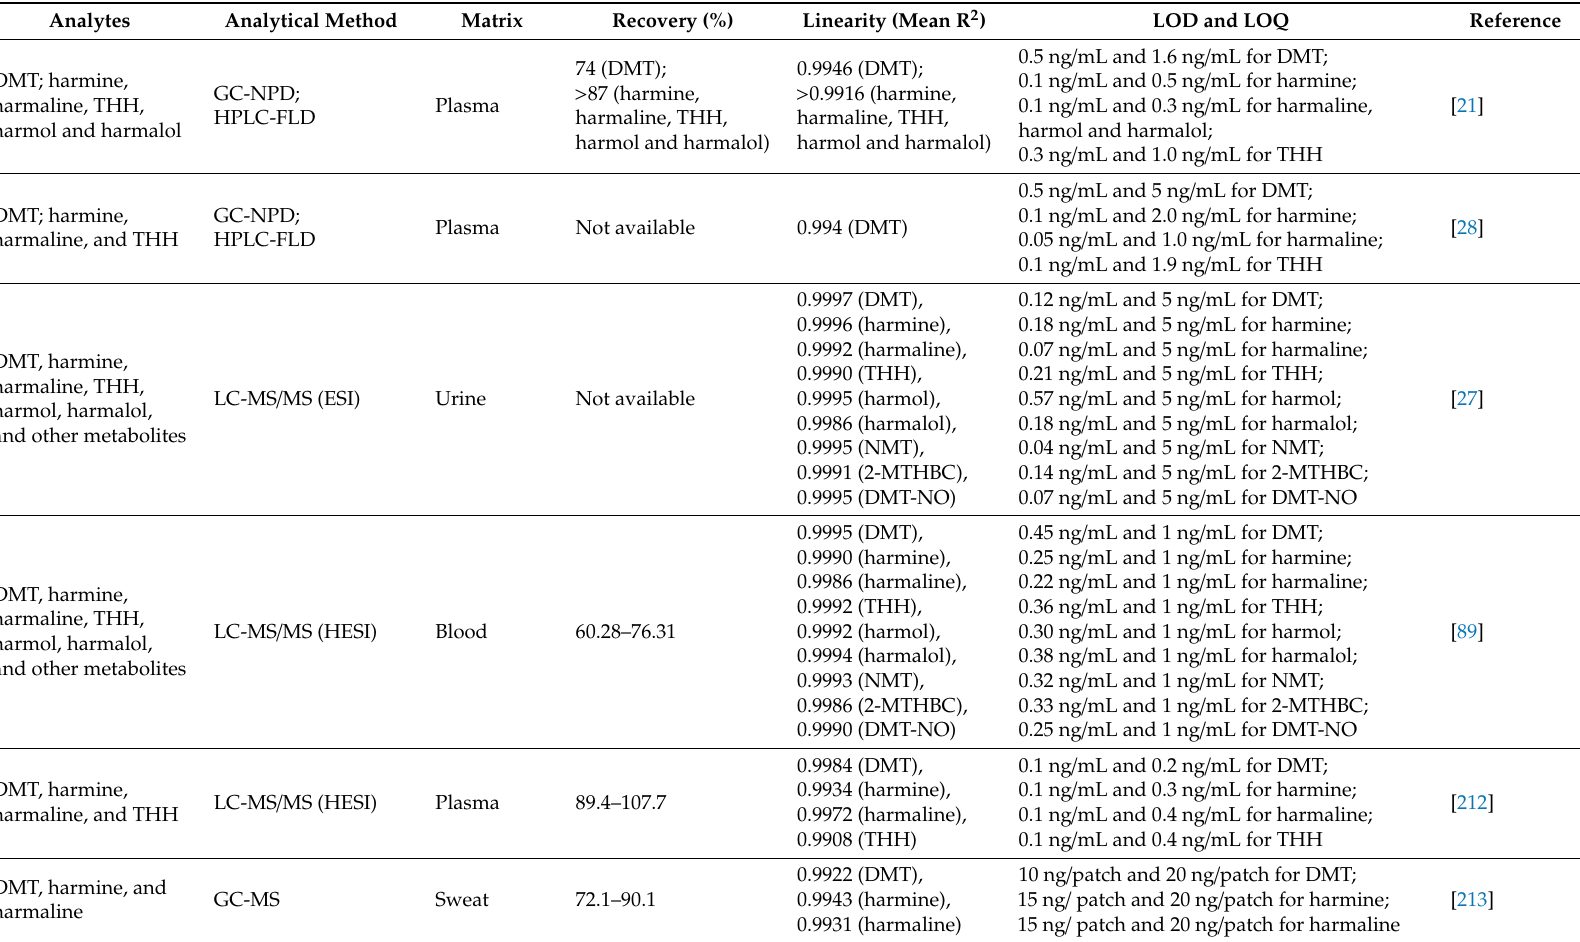
Table 4. Analytical methods for detection and quantification of the major compounds of ayahuasca in biological